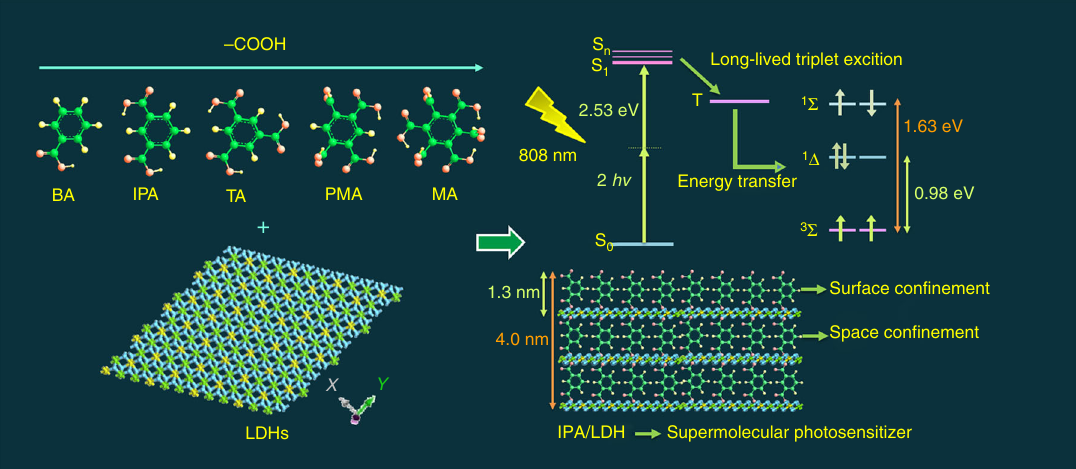
Fig. 1 Illustration of nanohybrids as two-photon photosensitizers for the 1 O 2 generation. Schematic representation of the LDH host and fi ve aromatic RTP guest species, as well as the 2D con fi ned long-lived triplet excitons can function as a photosensitizing means to achieve ef fi cient 1 O 2 generation under an 808 nm NIR